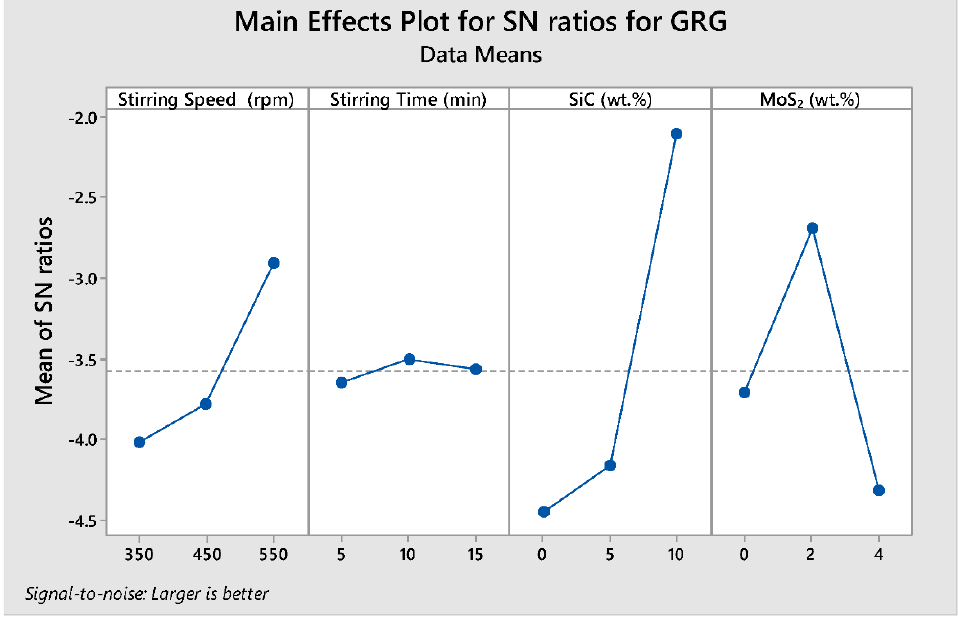
Figure 9. Main effect plots for S/N ratio of GRG.